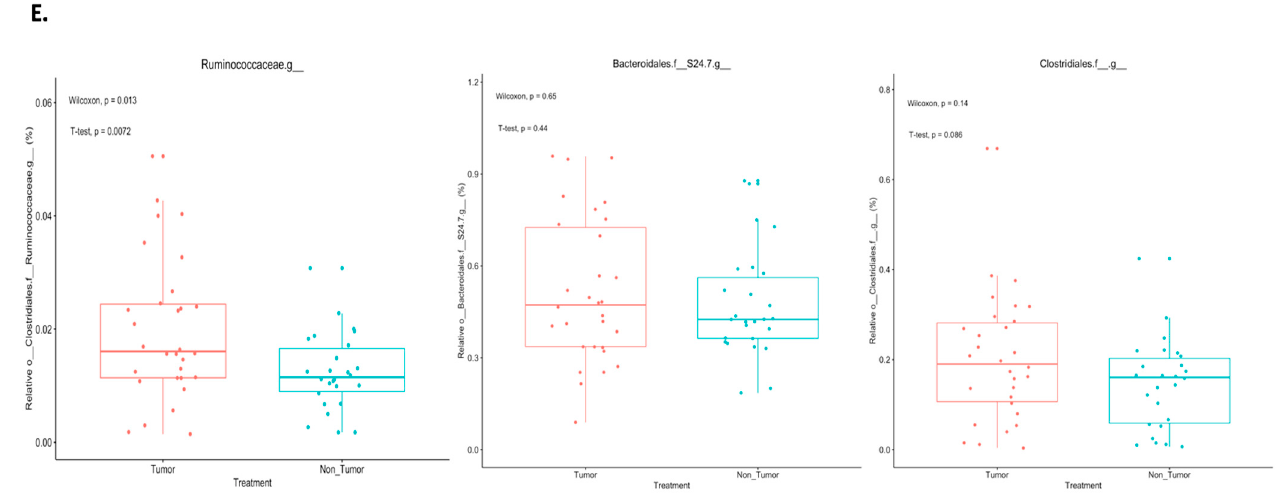
Figure 2. Co-occurrence changes between Bacteroidales.f__S24.7 , Clostridiales, and Ruminococcaceae occur with tumor presence. ( A , B ) Pearson correlation matrices were determined for microbiotas from tumor and nontumor mice and displayed using Cytoscape. From these visualizations, Bacteroidales.f__S24.7 co-occurrences greatly changed with tumor presence. ( C , D ) Using the R programming language, it was found that the most dramatic shifts of Bacteroidales.f__S24.7 were in conjunction with Clostridiales and Ruminococcaceae . ( E ) When comparing each taxon individually between tumor and nontumor, only Ruminococcaceae was significantly different.